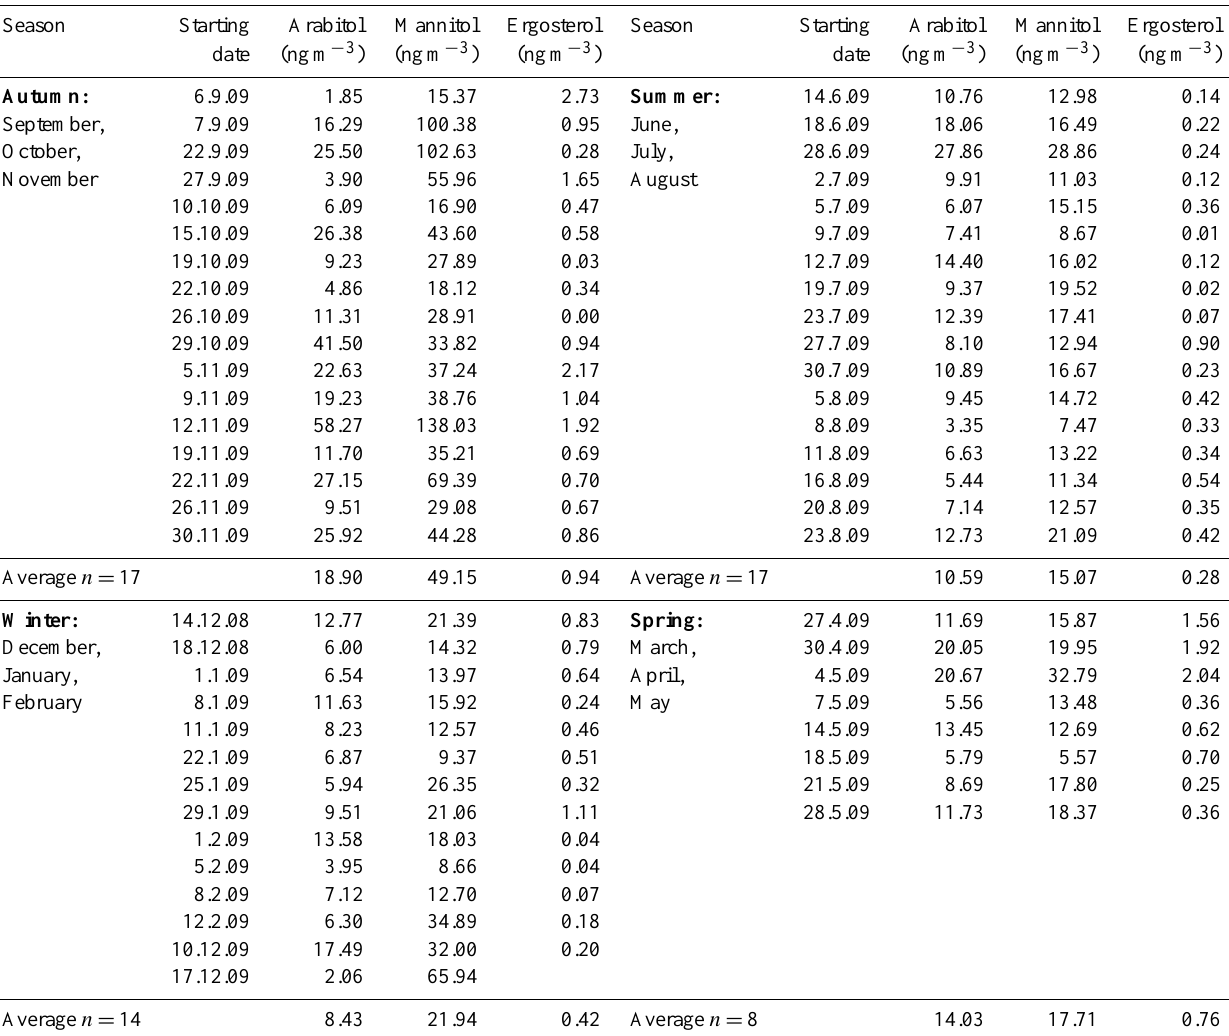
Table 1. Biomarkers levels were detected in each of the sampling dates (ngm − 3 ) . Each date shown represents the starting date of the sampling period during 72h. Averages are shown for each biomarker in all seasons. Arabitol, mannitol and ergosterol show the highest average concentrations during the autumn season, the lowest levels are seen during summer for ergosterol and mannitol and during winter for